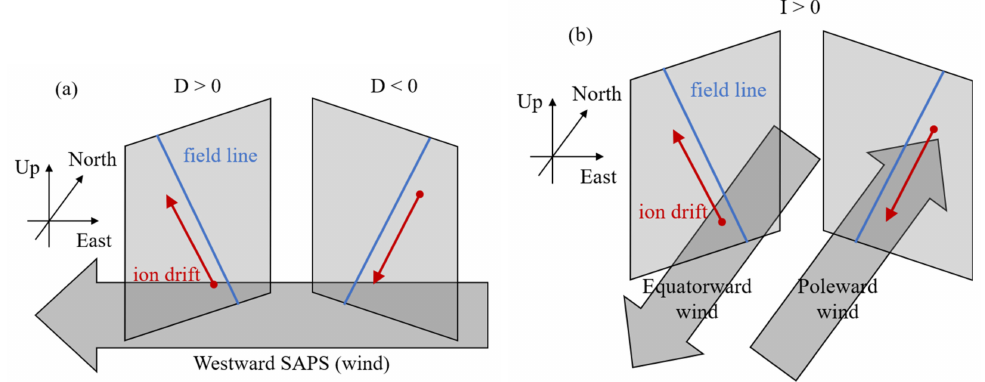
Figure 8. A schematic illustration of vertical ion drift in the Northern Hemisphere caused by ( a ) westward wind in the presence of declined magnetic field lines, and ( b ) meridional wind in the presence of inclined magnetic field lines in the SAPS